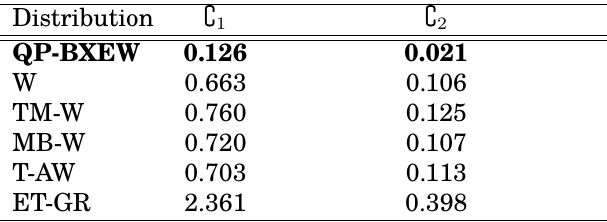
Table 5: (cid:123) 1 and (cid:123) 2 for the remission times data